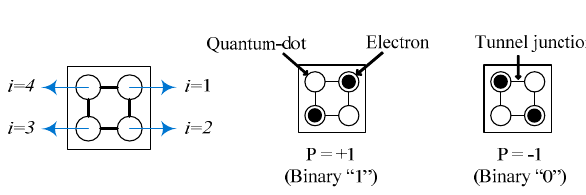
Figure 1. QCA cell with two possible polarizations.